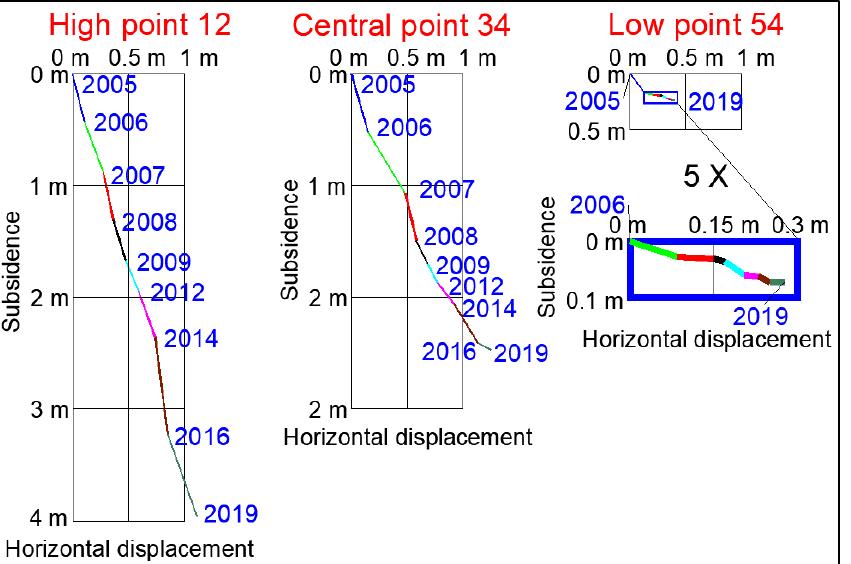
Figure 7. Displacements in the period 2005–2019 of points in the upper (point #12), central (point #34) and lower (point #54) parts of the front of the rock glacier.